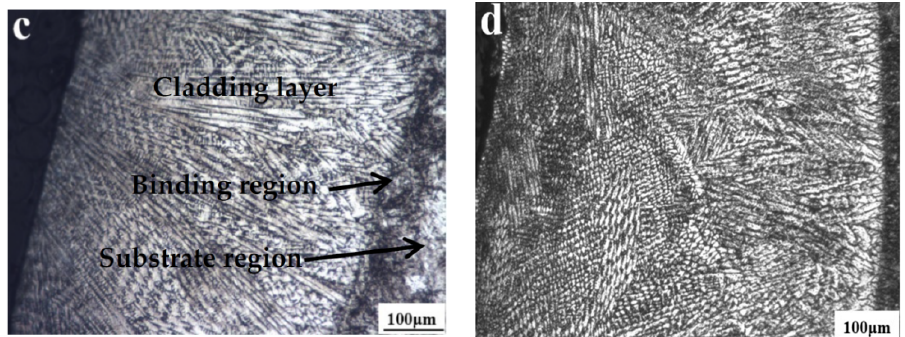
Figure 2. Metallographic structure of cladding layers: ( a ) microstructure of the cladding layer of AlCoCrFeNi(WC) 0 and substrate; ( b ) microstructure of the cladding layer of AlCoCrFeNi(WC) 0.1 and substrate; ( c ) microstructure of the cladding layer of AlCoCrFeNi(WC) 0.2 and substrate; ( d ) microstructure of the cladding layer of AlCoCrFeNi(WC) 0.3 and substrate.